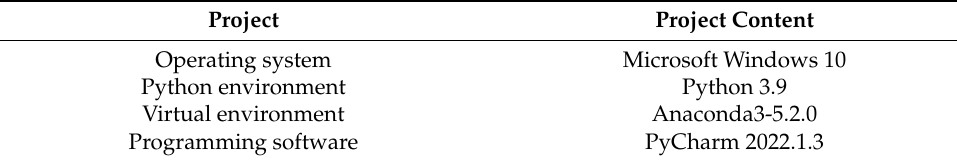
Table 1. Operating